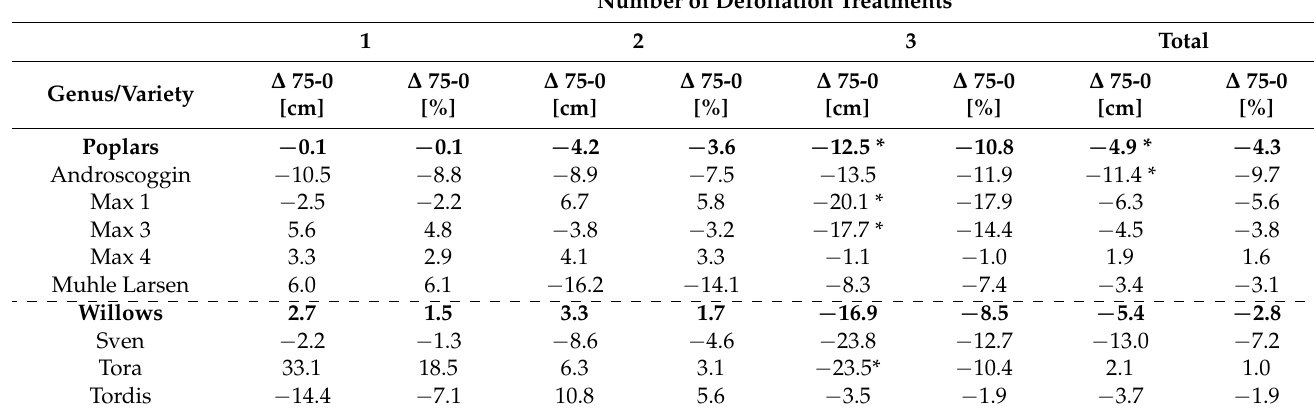
Table 8. Height differences of 75% defoliated and undefoliated plants ( ∆ 75-0) on the study site in Großthiemig in June 2009 after a harvest in March 2009 with regard to the number of defoliation treatments in 2007 and 2008 (* statistically significant difference according to the t test).